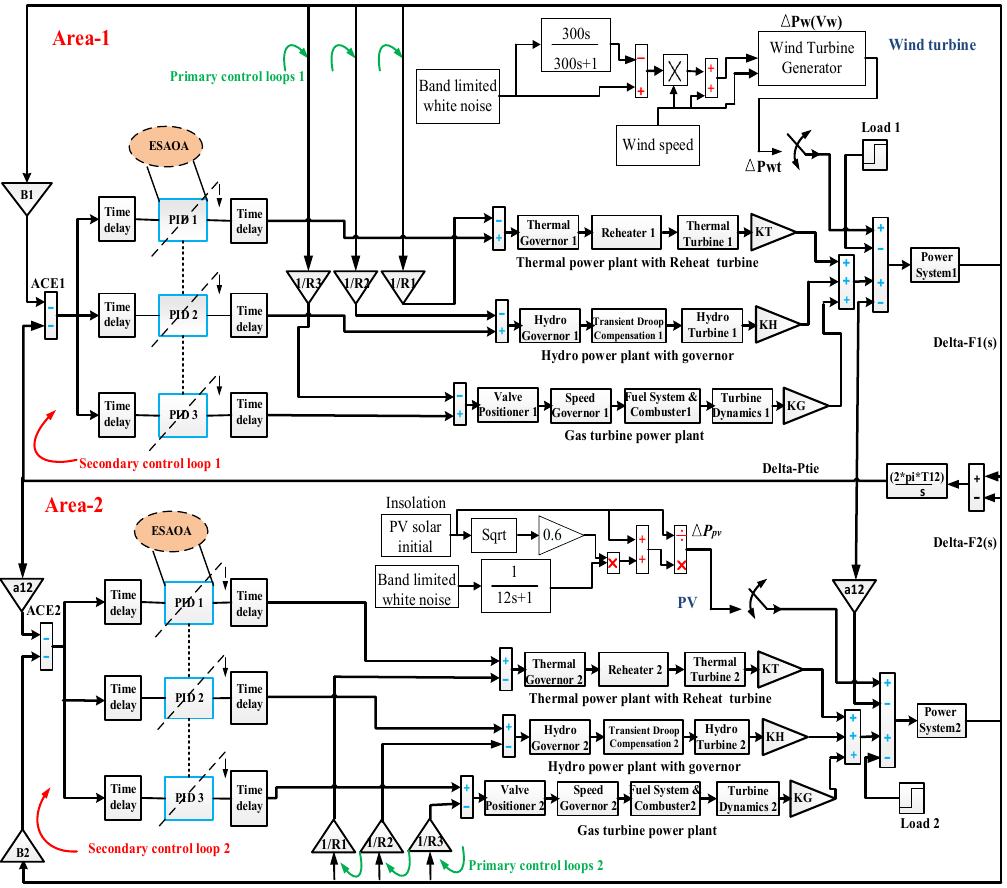
Figure 2. The transfer functions of the studied two-area interconnected power grid.